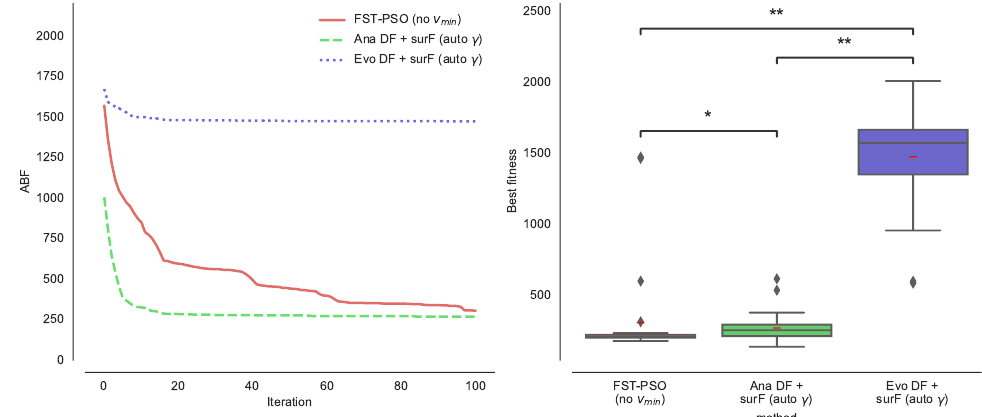
Figure 10. ( Left ): convergence plot of the PE of the MM model obtained with FST-PSO (no v min ) (coral solid line), FST-PSO using the analytic DF + surF (green dashed line), FST-PSO using the